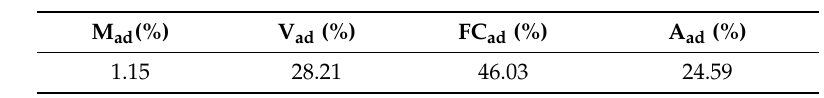
Table 1. Proximate analysis of the coal sample.